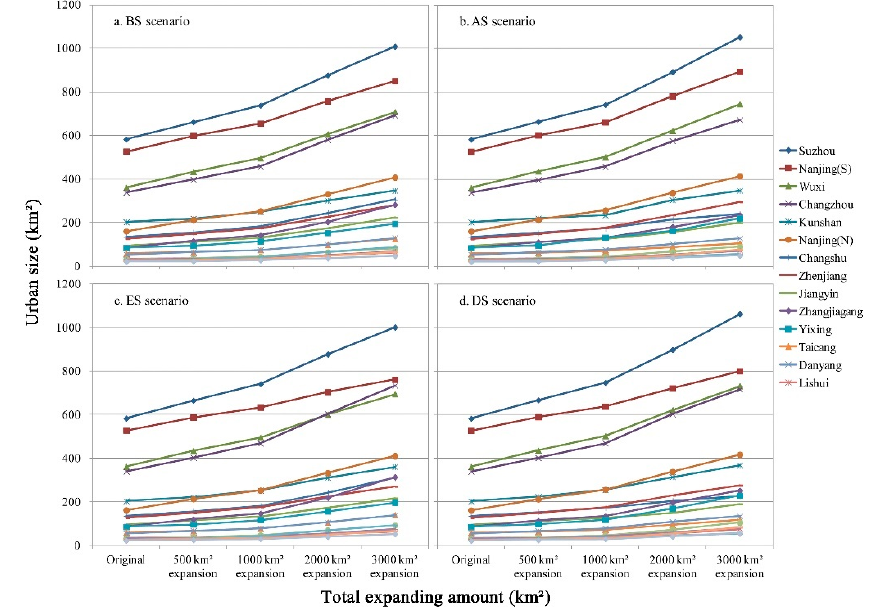
Figure 9. Urban rank-size changes under different scenarios. Table 4. Correlation coefficient of urban sizes and their existing areas under four scenarios.